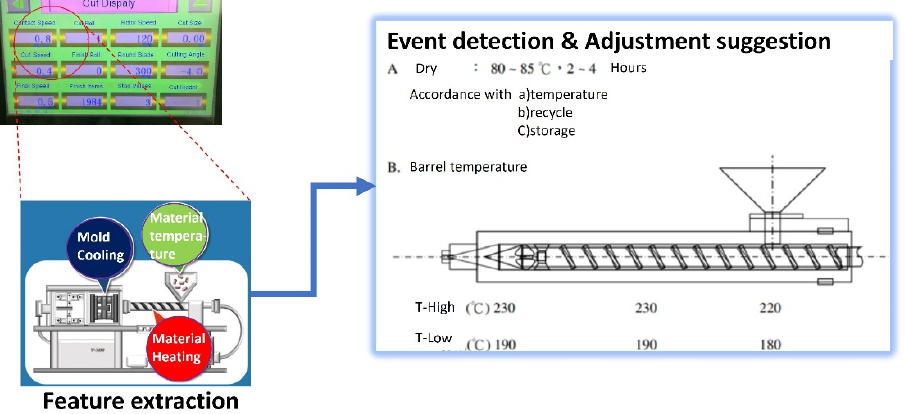
Figure 8. The mapping of the proposed IoT to real production process.